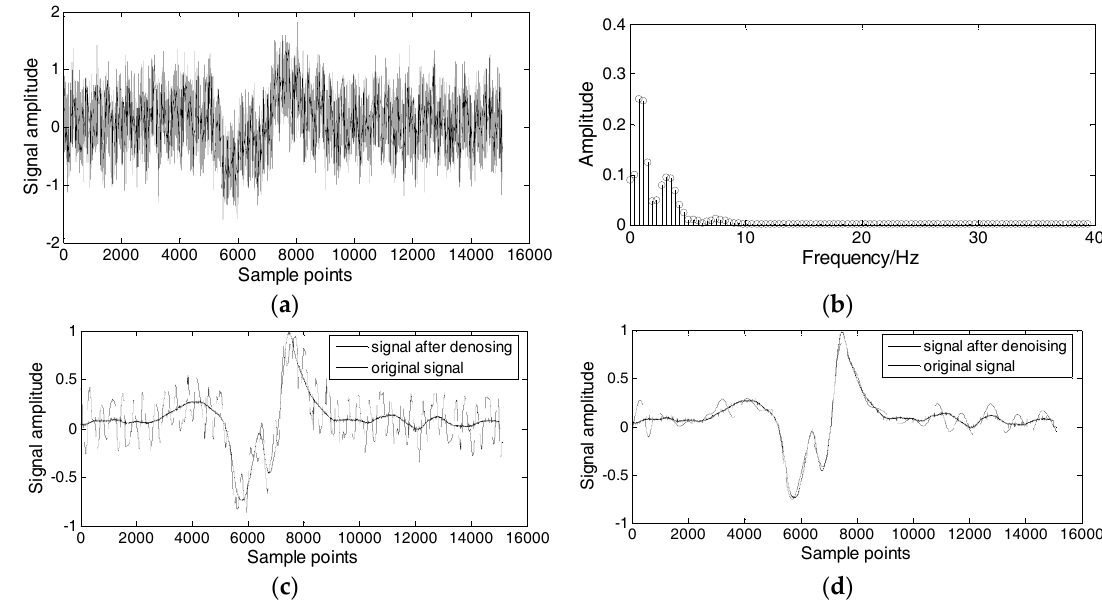
Figure 8. Comparison of two noise reduction methods for joint electromagnetic signal: ( a ) Joint electromagnetic signal with noise; ( b ) Normalized spectrum diagram of joint signal; ( c ) Denoised result by improved threshold wavelet; ( d ) Denoised result by combined use of improved threshold wavelet and EMD.